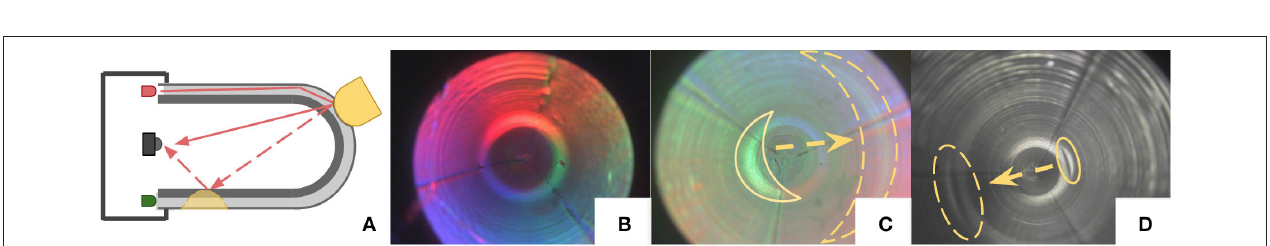
FIGURE 6 | (A) Illustration depicting the cause of ghost contacts . Due to the sensor geometry, lighting, and surface characteristics, the light rays initially guided through the elastomer are diverged by a (real) contact imprint, and consequently are projected onto the opposite side of the sensor, resulting in a second ghost contact . (B–D) Comparison of different paints: silicone with aluminum powder (only), metallic elastic paint and silicone with a mix of aluminum and Silver Cast Magic ® powders. In (B) and (C) , RGB lighting is used, and in (D) white lighting is used. In (B) and (C) , due to the illumination and paint reflectiveness, the discontinuity region generates a bright reprojection on the opposite side of the sensor. In (D) , the contact existing in that region is also projected as an artifact that we refer to as ghost contact .